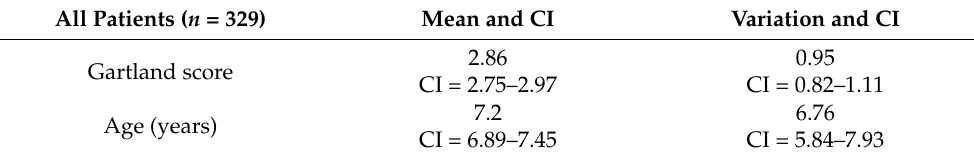
Table 1. Patient s’ demographics ( n = 329).